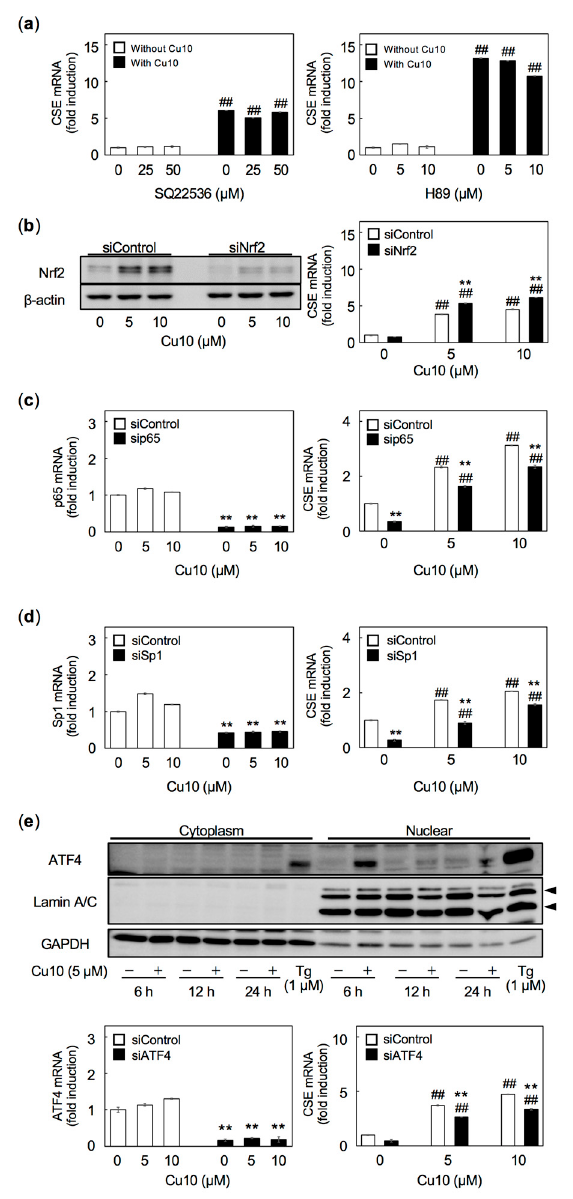
Figure 5. Possible involvement of cyclic AMP mediated signaling and transcription factors—Nrf2, NF κ B, Sp1, and ATF4—in the induction of CSE transcription by Cu10. ( a ) Possible involvement of cyclic AMP in the induction of CSE transcription in vascular endothelial cells treated with Cu10. Densely cultured bovine aortic endothelial were pretreated with the adenylate cyclase inhibitor SQ22536 (25 and 50 µM) (left panel) or the protein kinase A inhibitor H89 (5 and 10 µM) (right panel) for 1 h, then treated with ( ■ ) or without ( □ ) Cu10 (5 µM) for 12 h. Values are mean ± SE of three samples. ## Significant difference from the corresponding vehicle control (no Cu10), p < 0.01. ( b ) Possible involvement of Nrf2 in the induction of CSE transcription in vascular endothelial cells treated with Cu10. Nrf2 protein expression (left panel). Confluent cultures of bovine aortic endothelial cells were treated with Cu10 (5 and 10 µM) for 6 h. The results of the densitometric analysis are shown in Figure S4. CSE mRNA level (right panel). Subconfluent cultures of bovine aortic endothelial cells were transfected with control or Nrf2 siRNA for 4 h and treated with ( ■ ) or without ( □ ) Cu10 (5 and 10 µM) for 12 h. Values are mean ± SE of three technical replicates. ** Significant difference from the corresponding siControl, p < 0.01. ## Significant difference from the corresponding vehicle control (no Cu10), p < 0.01. ( c ) Possible involvement of NF- κ B in the induction of CSE transcription in vascular endothelial cells treated with Cu10. p65 mRNA (left panel) and CSE mRNA (right panel).